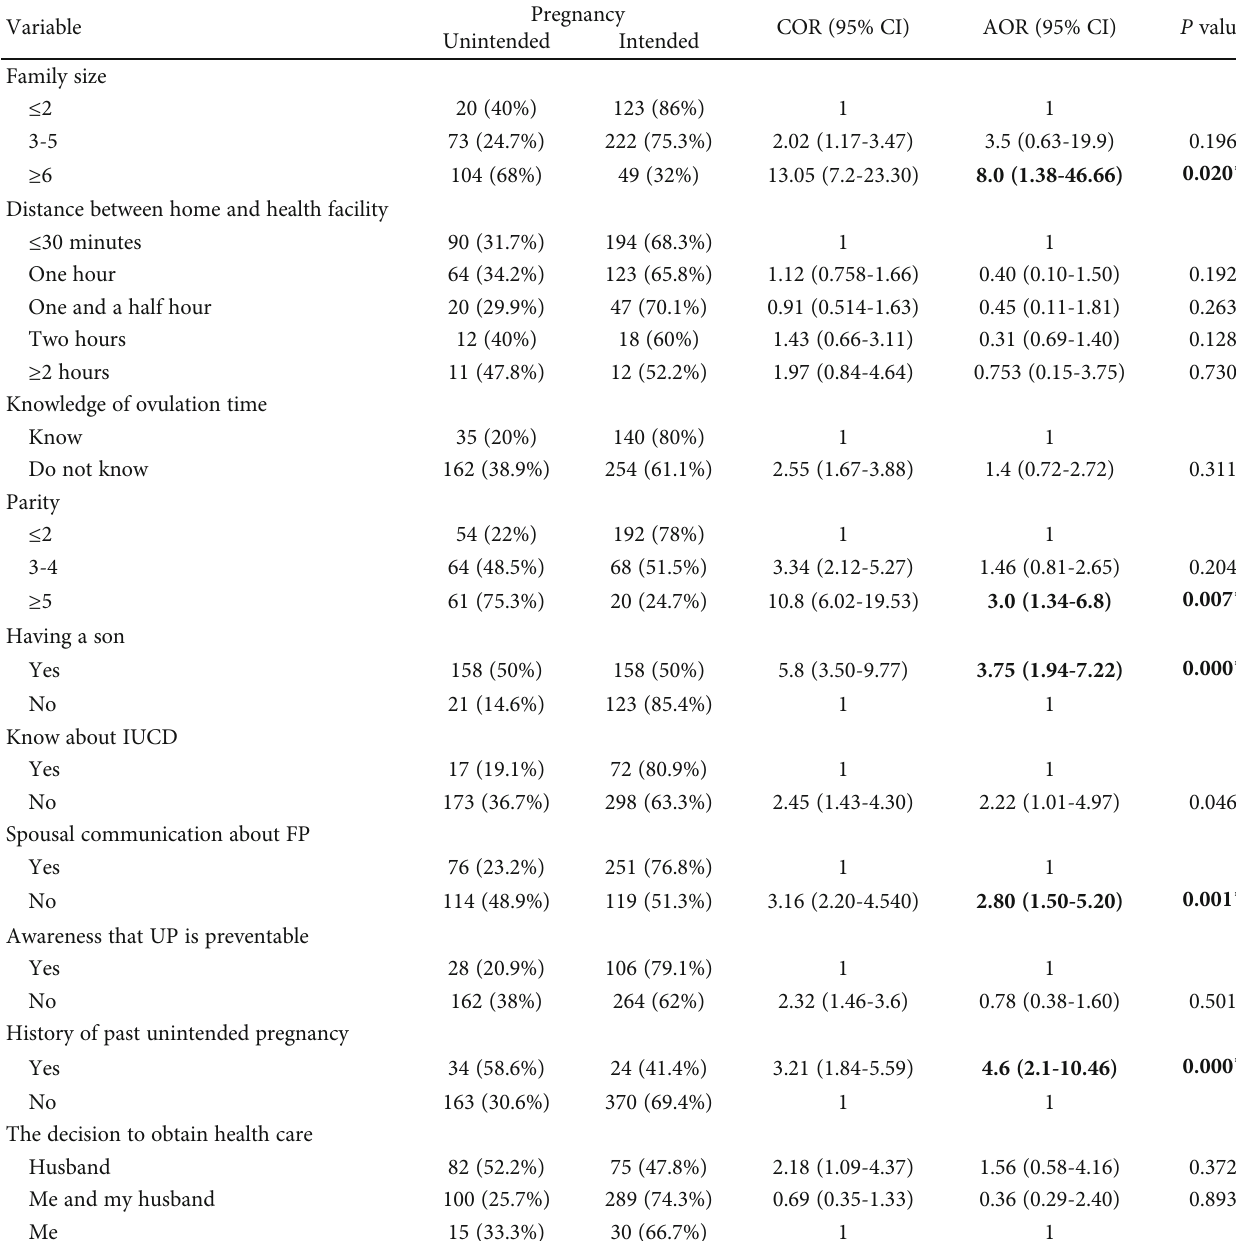
Table 4: Multivariable analysis of factors associated with unintended pregnancy among women attending ANC in a public health facility in Bako Tibe district, Oromia, Ethiopia, 2019 ( n = 591